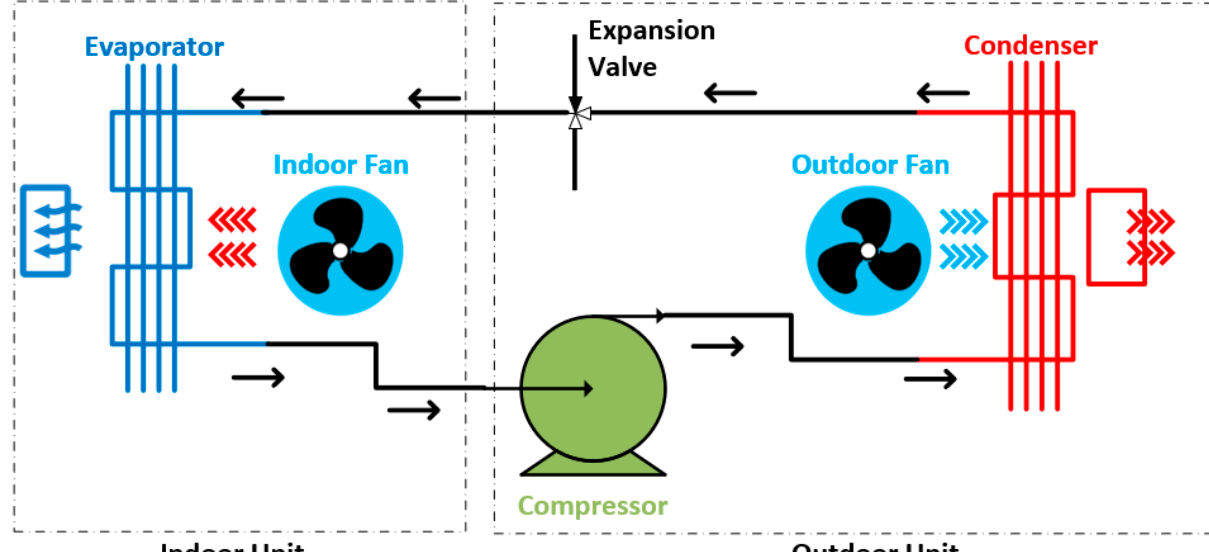
Figure 1. HVAC thermodynamic process .